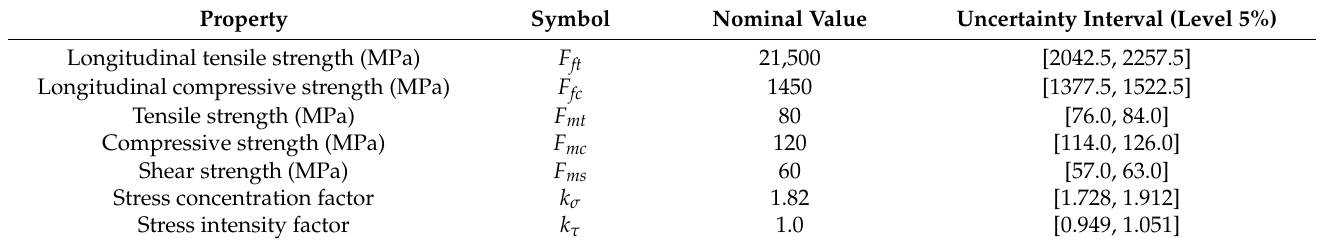
Table 4. Nominal values and uncertainty intervals of the strengths of the fibers and the matrix of